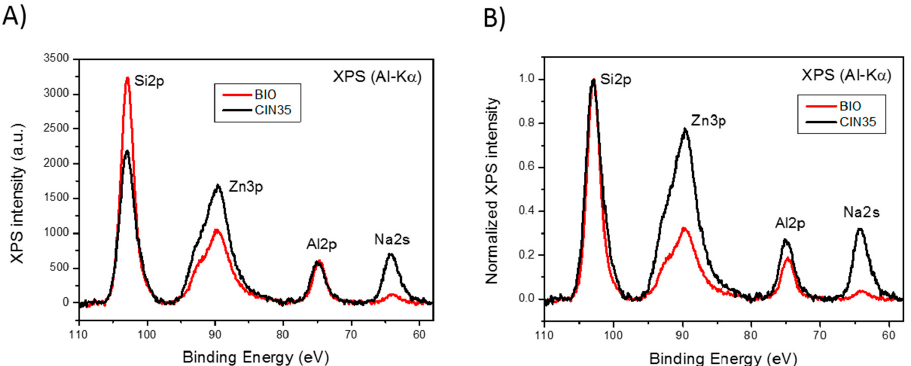
Figure 3. X-ray photoelectron spectroscopy (XPS) spectra in the Si2p, Zn3p, Al2p, and Na2s region of the ZnO35 pellet and the ZnO35 pellet after being immersed for 40 days in LB (labelled as BIO). ( A ) XPS signals upon background subtraction; ( B ) signals normalized to the Si2p peak upon background subtraction.